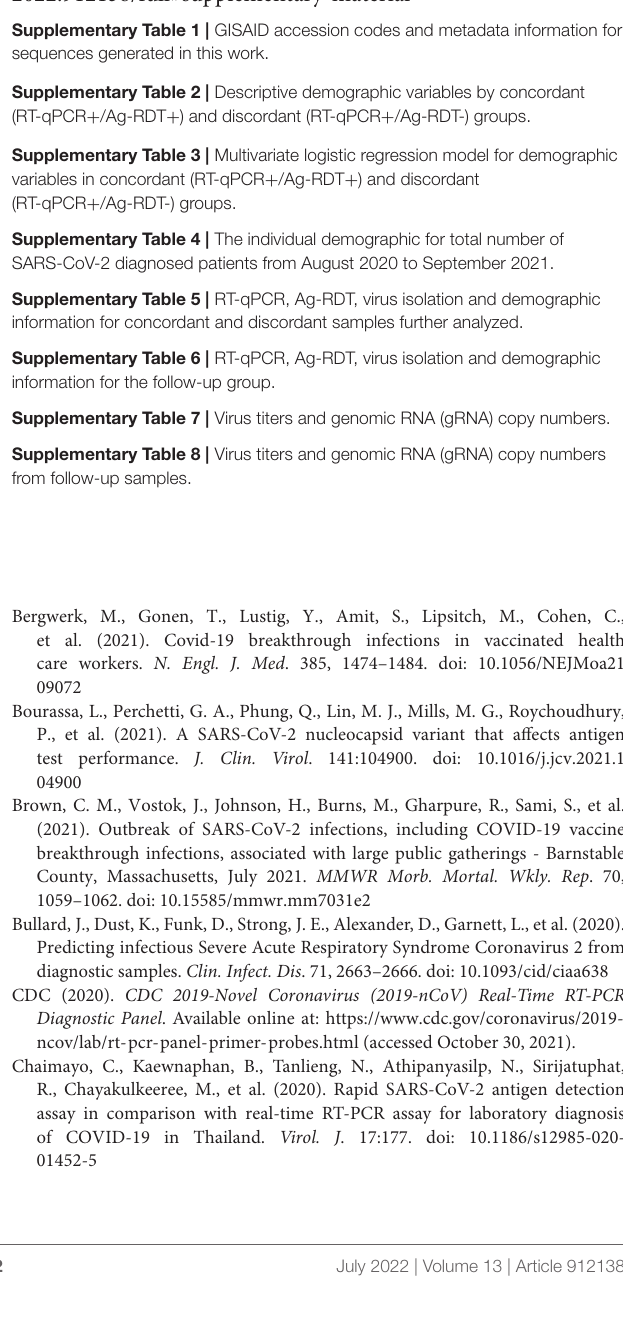
Supplementary Table 1 | GISAID accession codes and metadata information for sequences generated in this work.